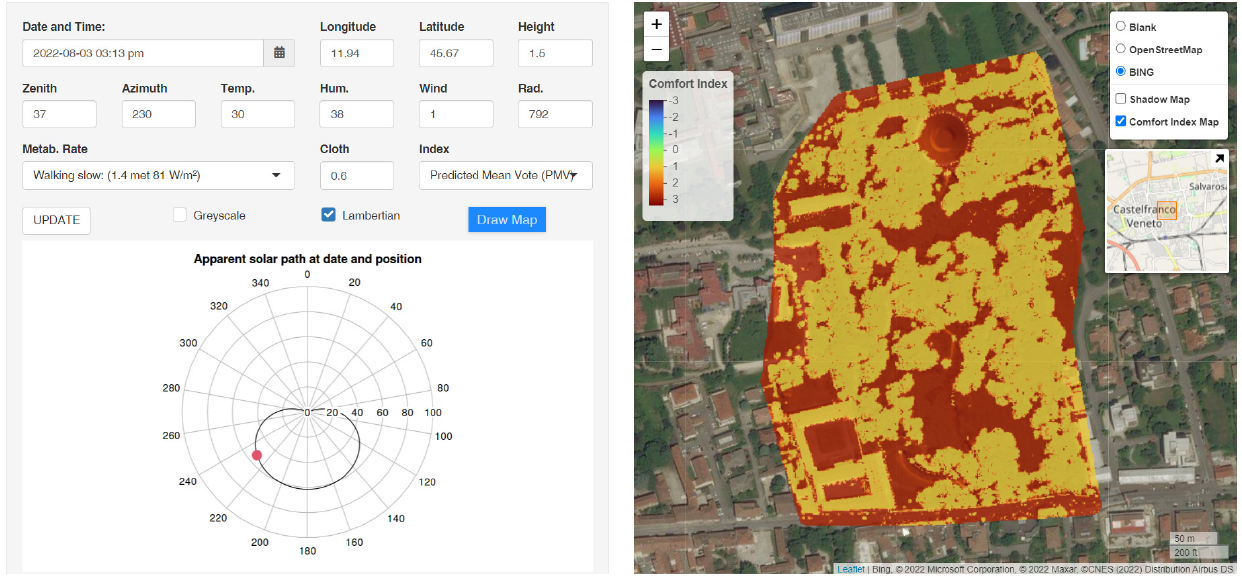
Figure 6. The interface of the webapp: in the left panel, from top to bottom, we have information about the time of day and geographic coordinates used to calculate the sun position (zenith and azimuth). The “height” is the height above the ground for which to calculate the comfort indices. The zenith and azimuth can be changed by the user or changed automatically if the date or geographic coordinates are changed. The four environmental variables can also be changed by the user or they are extracted from the sensors in the park. The metabolic rate and clothing can be selected, as well as the index to be calculated. The update extracts all information from the current time and date. The Greyscale option applies a grey color-scale mapping to the shadow map. The Lambertian option applies perfectly diffuse backscatter behavior of light. The bottom-left diagram is the sun position and track for the position and day of the year chosen in the top row of the input. The right panel is the mapped comfort values over a web-gis interface that allows navigating over Microsoft Bing imagery (API key required if implementing on your own).